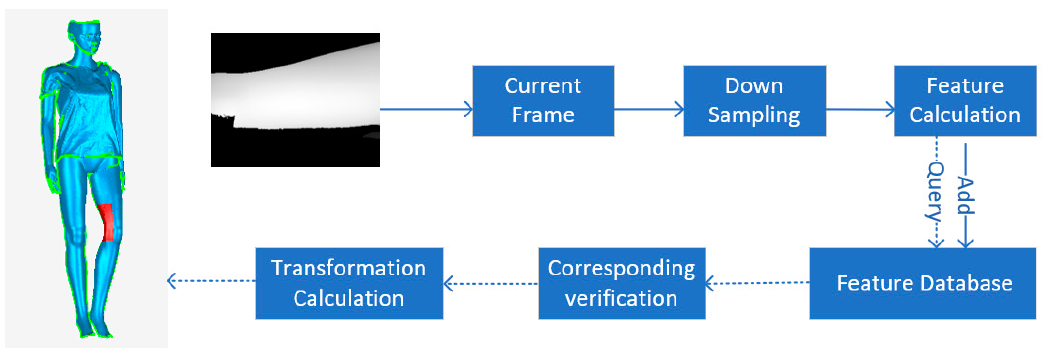
Figure 1. Proposed global relocation algorithm pipeline.